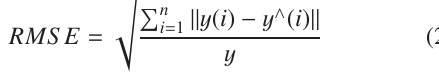
Table 1. A sample of input dataset